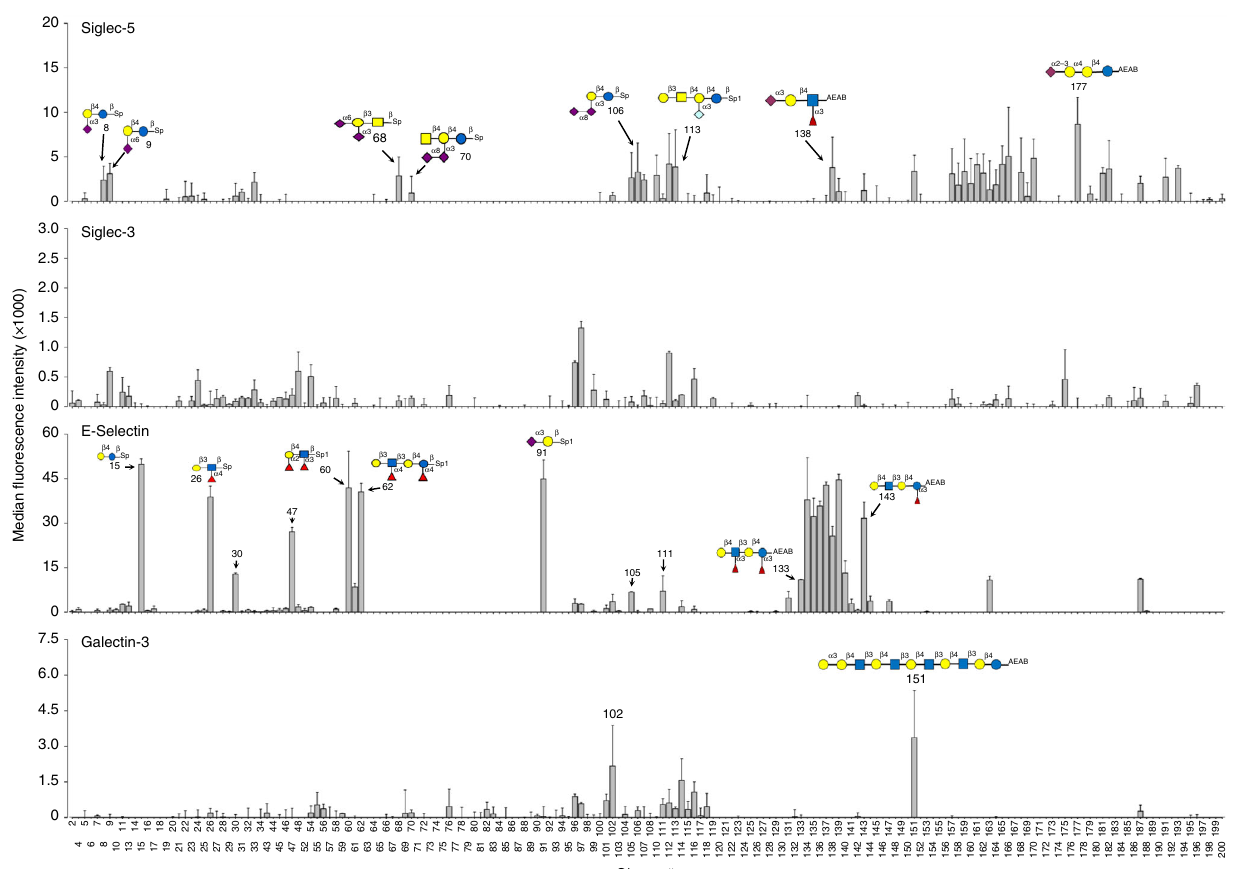
Fig. 4 MGBA ’ s speci fi city for glycan-binding proteins. The data for four representative GBPs are shown here and the data for other GBPs are shown in Supplementary Fig. 7. Representative glycans binding to the GBPs are shown for siglec-5 (top), E-selectin (lower middle) and galectin-3 (bottom). Mean of two replicates is presented and error bars are standard deviations of the two replicates. The experiment was repeated three to test the MGBA recognizes (Fuc- α 2)-Gal- β 4-x motif. If the motif changes to BGH-type 1 as in glycan #123 [(Fuc- α 2)-Gal- β 3- x ] or (Fuc α 1-3)-Gal β 4-x as in glycan #32, binding is abolished (Fig. 3b). The monoclonal antibody raised against GA1 structure (Gal- β 3-GalNAc- β 4-Gal- β 4-Glc) speci fi cally binds to glycan #171 as expected. The Le b antibody recognized the Le b glycans (#61 and 137) but also bound to several glycans containing Gal- β 4-Glc (#15 ) and Gal- β 3-(Fuc- α 4)-GlcNAc (#26, 62,135 and 136) structures. The Lac/Gal- β 4-Glc- β (#15) structure was recognized by CA19.9 (IgG and IgM class), sLe x , and Le b antibodies (Supplementary Fig. 6).